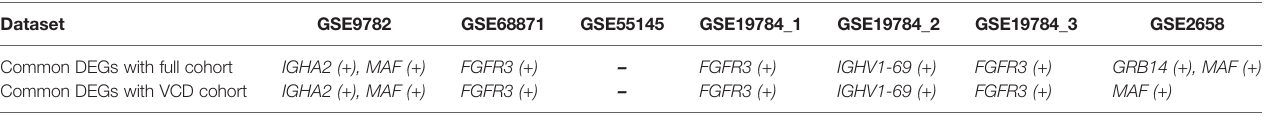
TABLE 6 | Common differentially expressed genes (DEGs) in the current experimental dataset (full or VCD only cohorts) and in seven previously published MM datasets. Dataset